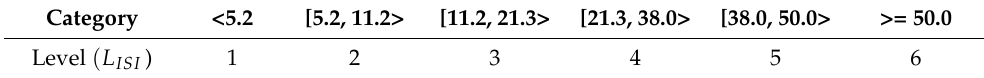
Table 3. Fire Weather Index (FWI) categories [47].